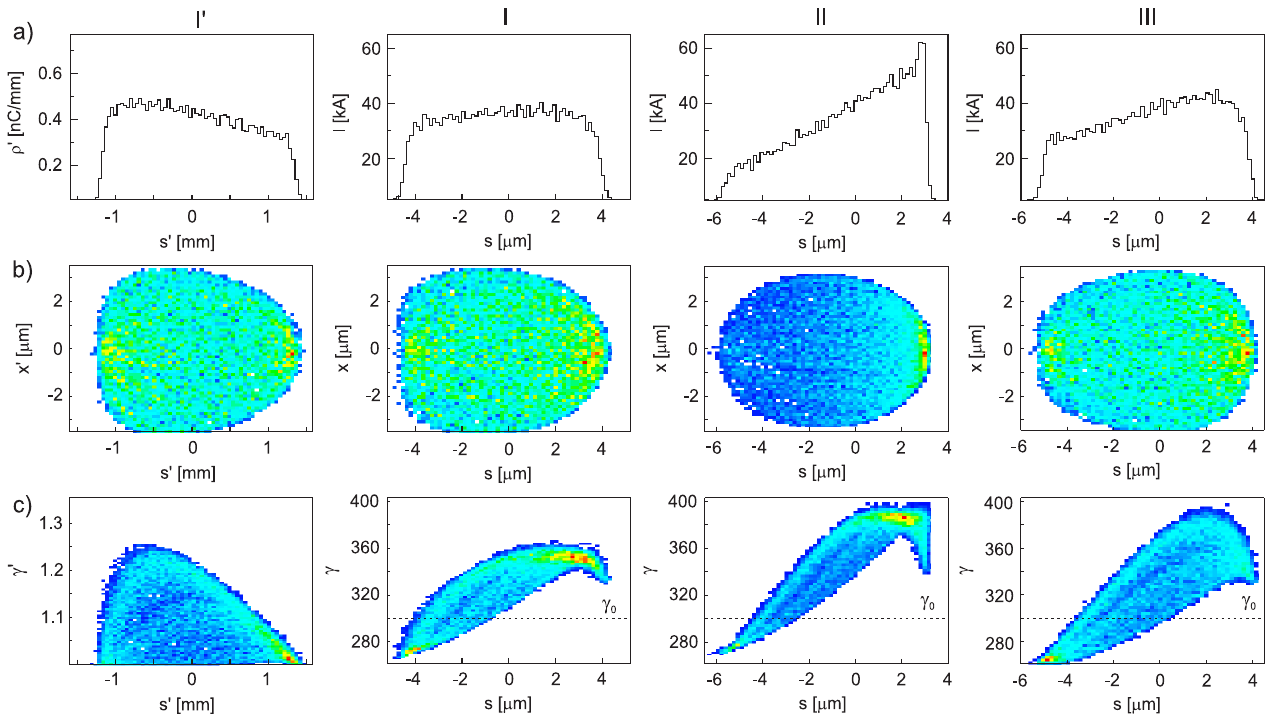
FIG. 3. (Color) Calculation of the vacuum expansion of the considered electron bunch is shown with the initial state as illustrated in Fig. 1 after the propagation distance of 1.8 m corresponding to 6 ns in the laboratory frame or after 20 ps in the mean rest frame. The P P (cid:5) ð t Þ s ð t Þ = (cid:5) ð t Þ . Panels in column I 0 show the calculation with negligible retardation artifacts center of mass is located at s ¼ 0 ¼ i i i i i in the mean rest frame and panels in column I show the Lorentz-transformed results [Eqs. (2)] in the laboratory frame. Column II shows the PPI calculation performed in the laboratory frame and column III shows the calculation result corresponding to a Poisson solver, both with instantaneous onset of the Coulomb interaction. The longitudinal spatial inner bunch position is plotted in the mean rest frame ( s 0 ) and in the laboratory frame ( s ). Part (a) in column I 0 shows the line charge density distribution, parts (b) and (c) in column I 0 show the bunch current. Both of these representations are proportional to the longitudinal particle density. Row (b) shows the spatial particle density distribution with the transverse coordinate plotted in the mean rest frame ( x 0 ) and in the laboratory frame ( x ). Row (c) shows the longitudinal phase space. The color coding is linear and equivalent to the one of parts (b) and (d) in Fig.